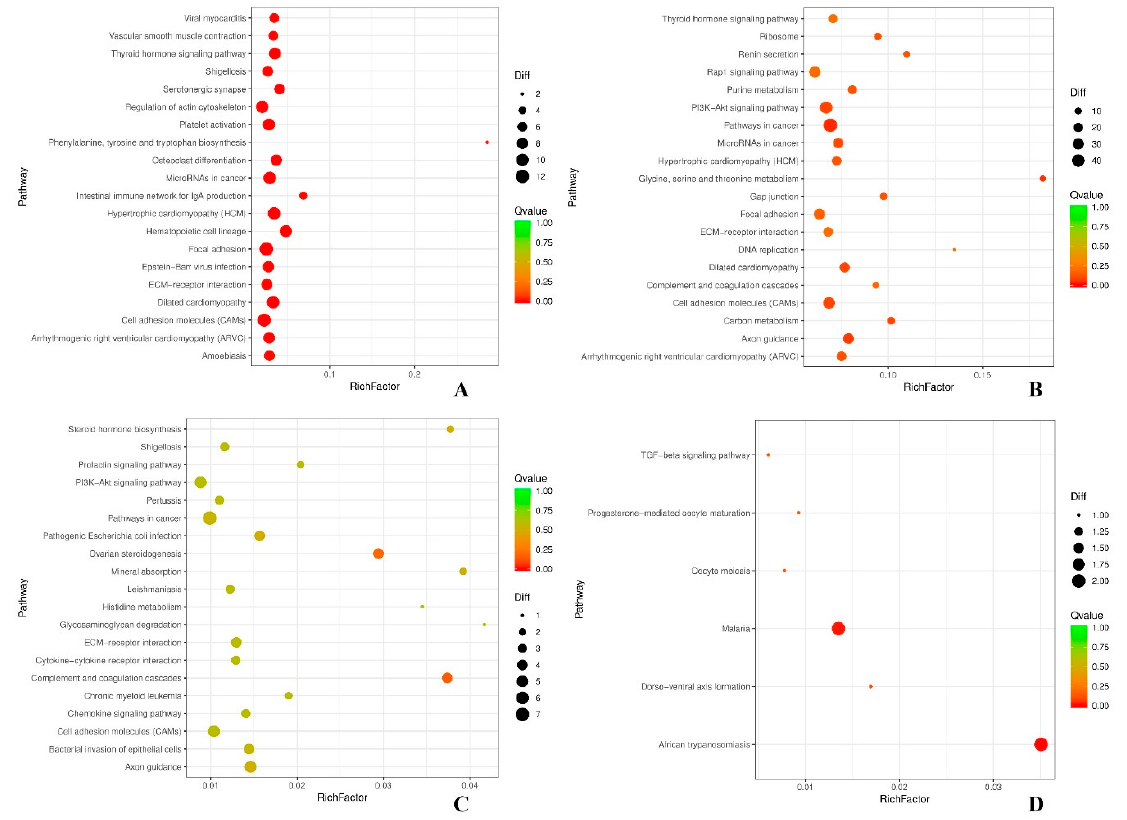
Figure 5. KEGG pathways for DEGs in ( A ) BH-vs-WH, ( B ) BL-vs-BH, ( C ) BL-vs-WL and ( D ) WL-vs-WH. Note: In the figure, each circle represents a KEGG pathway, the name of which being Scheme 3. 4. Verification of Differentially Expressed Genes.